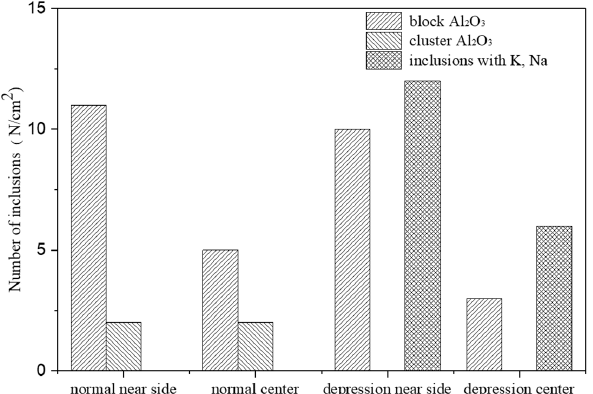
Figure 3. Distribution of inclusions in slab surface and subsurface.